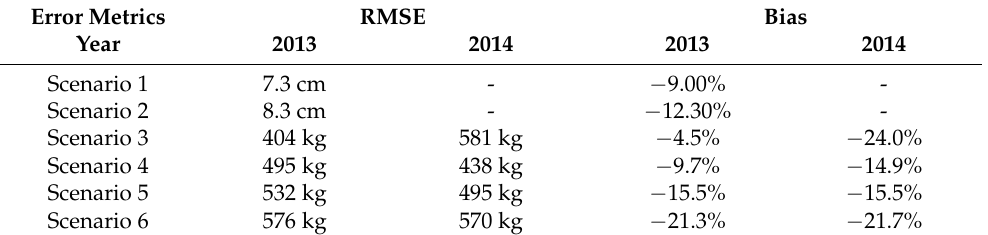
Table 3. The metric errors in the estimation of the DBH and AGB at the tree level in different scenarios.